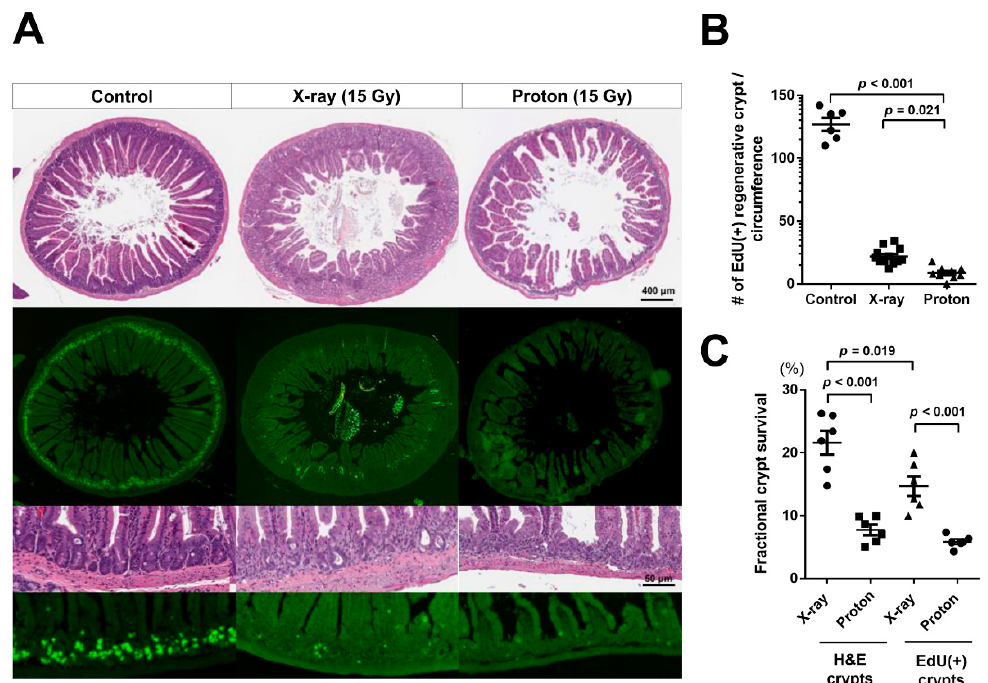
Figure 3. Proton irradiation decreases the number of regenerative crypts in the mouse jejunum to a greater extent than X-ray irradiation: ( A ) The representative H&E-stained (upper panels) and 5-ethynyl-2 ′ -deoxyuridine (EdU)-stained (lower panels) images of the jejunum sections 3.5 days postirradiation with 15 Gy of X-rays or protons are presented herein. Dividing S-phase cells were labelled by EdU administration 2 h prior to euthanasia. ( B ) The quantification showed a significant decrease in the number of EdU-positive crypts by proton irradiation compared with X-ray irradiation. EdU-positive crypt is defined as a crypt that contains five or more EdU-positive cells. ( C ) Fifteen Gy of X-rays or protons induced a more significant decrease in the number of EdU-positive crypts than H&E-stained crypts. The fractional crypt survival was defined as the ratio of crypt numbers in the irradiated sections to those in the unirradiated sections.